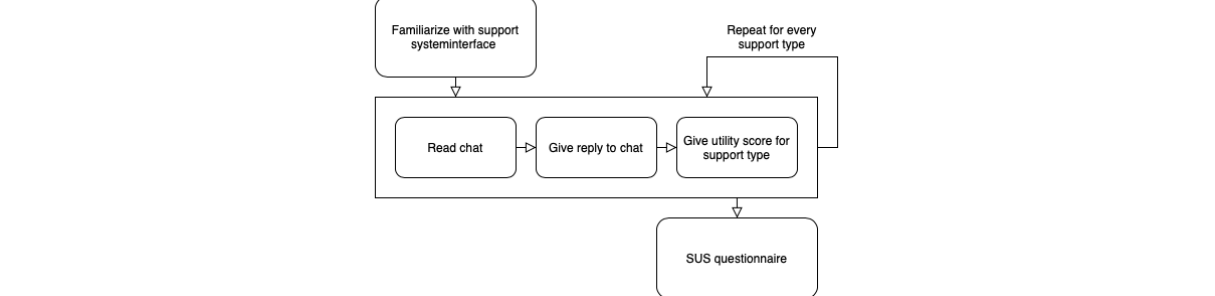
Figure 2. Procedure diagram of the first part of the experiment. SUS: System Usability Scale.